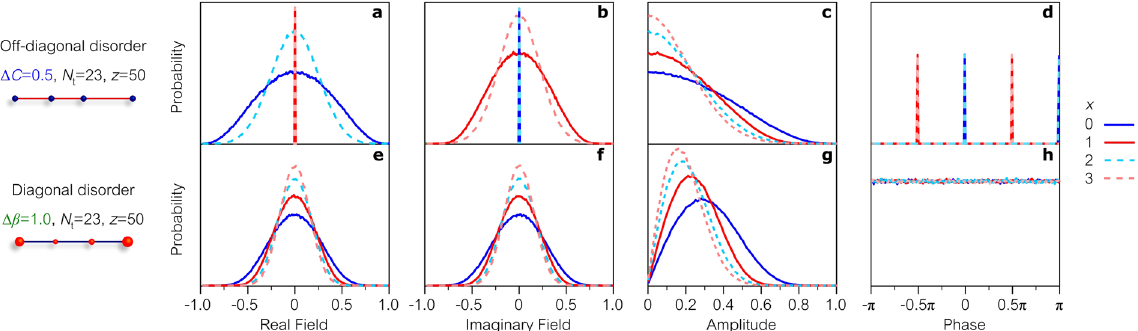
Figure 3. Probability distributions of the field quadratures, amplitude, and phase in linear disordered lattices. ( a – d ) Probability distributions of the ( a ) real quadrature, ( b ) imaginary quadrature, ( c ) amplitude, and ( d ) phase of the complex optical field at different output sites x after propagating through a photonic lattice with off- diagonal disorder. The real (imaginary) quadrature vanishes on the odd (even) sites, and the phase takes binary values with equal probability: 0 or π π ± ( /2) at even (odd) positions. ( e – h ) Same as in ( a – d ) for a lattice with diagonal disorder. The field is circularly symmetric, resulting in a uniform phase distribution. We use throughout ensembles of 10 5 realizations and a single lattice site ( = x 0 ) is excited.